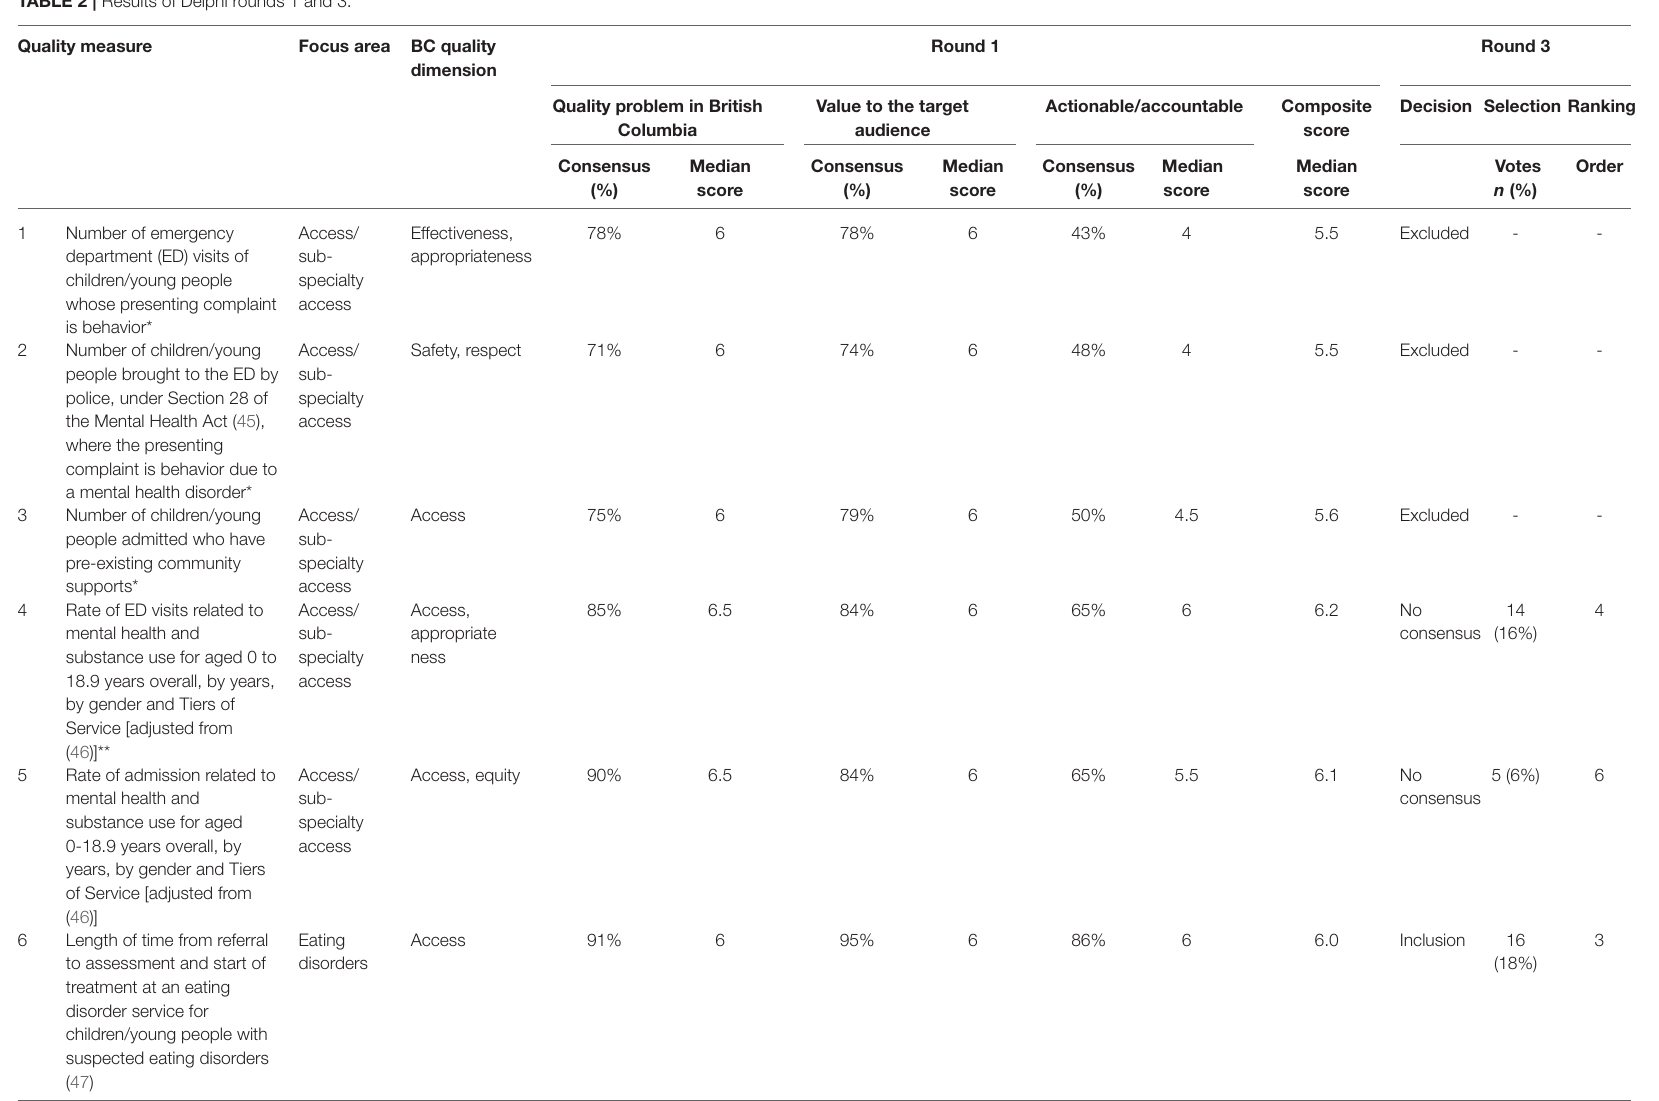
TABLE 2 | Results of Delphi rounds 1 and 3. Quality